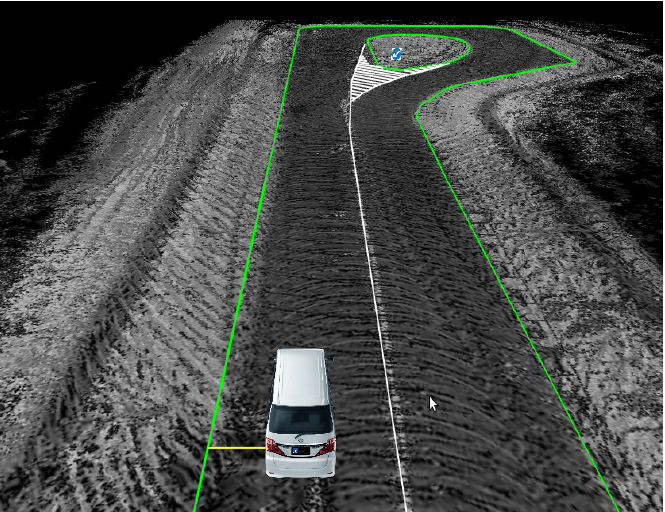
Figure 2. Lateral distance from the vehicle to the